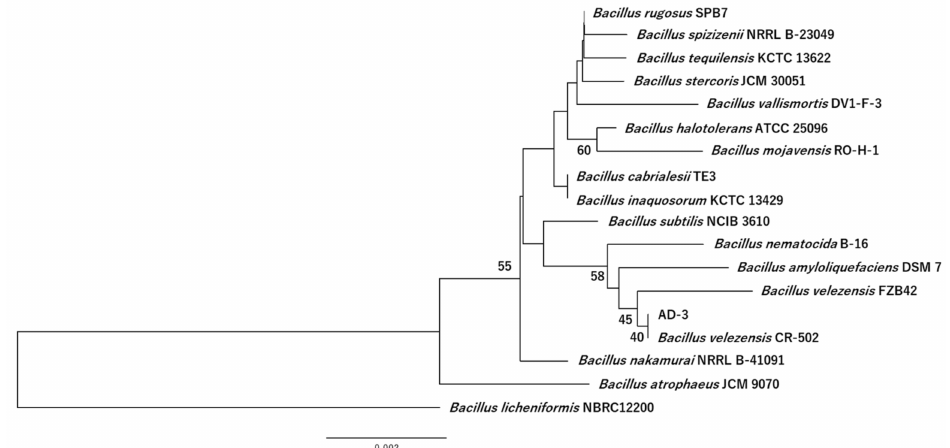
Figure 3. Phylogenetic tree based on 16S rDNA gene sequences of AD-3 strain and related species using neighbor-joining analysis. Bacillus licheniformis NBRC12200 served as an outgroup. Scale bar refers to a phylogenetic distance of 0.002 nucleotide substitutions per site. Bootstrap values were obtained based on 1000